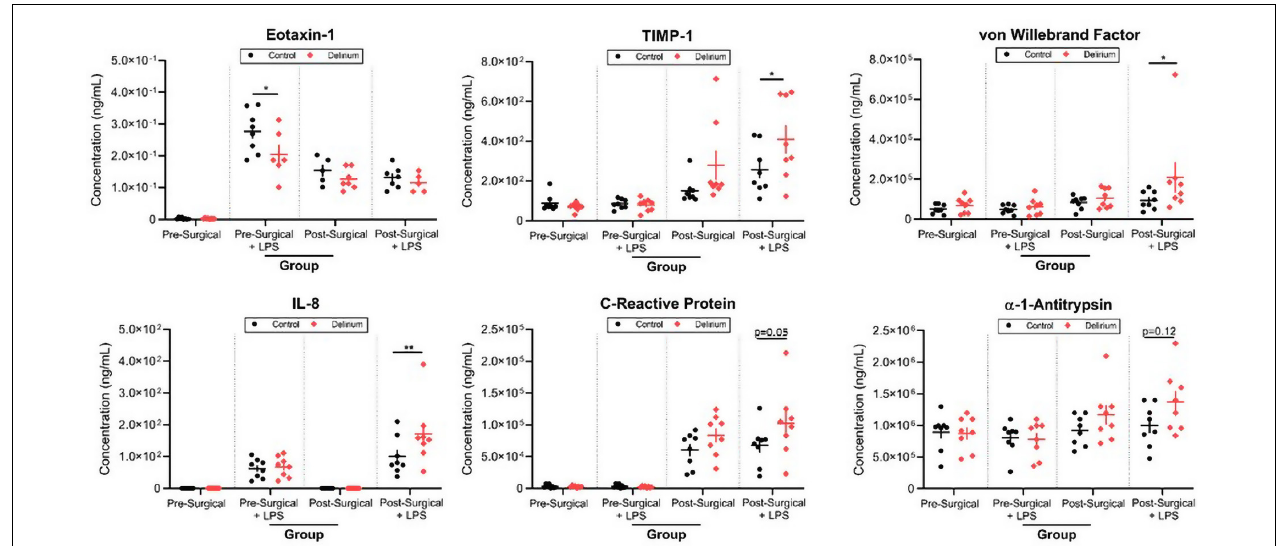
FIGURE 6 | Lipopolysaccharide (LPS) stimulation of preoperative and postoperative whole blood. Samples from patients with delirium exhibited differential responses to LPS treatment as measured by several inflammatory markers. TIMP-1, tissue inhibitor of metalloproteinases 1; IL-8, interleukin 8; LoD, limit of detection. * p < 0.05 and ** p <